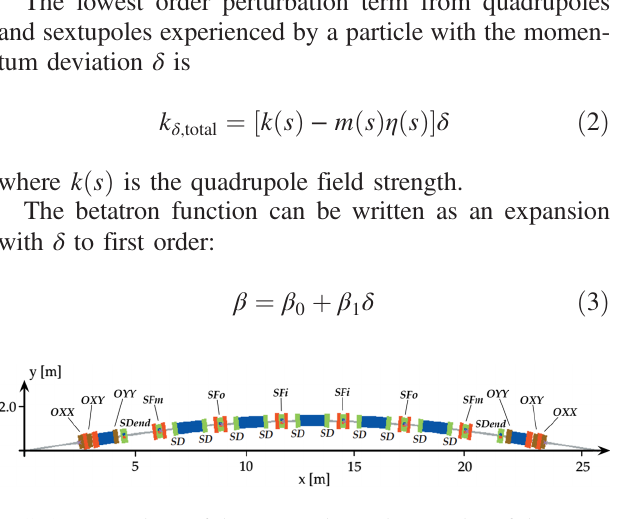
FIG. 2. Locations of the sextupoles and octupoles of the MAX IV 3 GeV storage ring